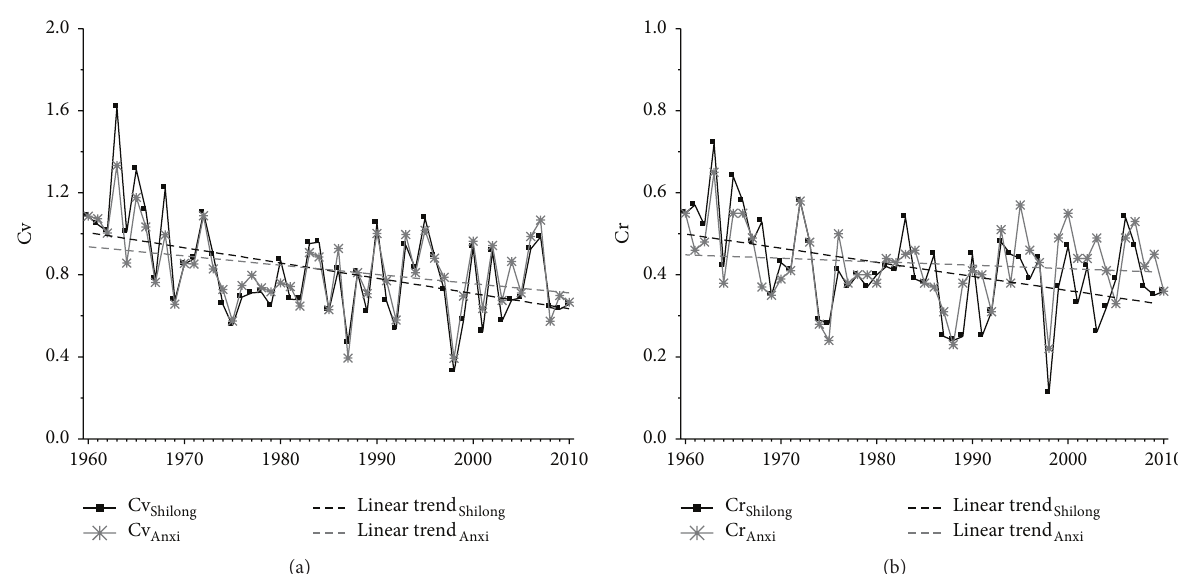
Figure 7: Interannual variation trend of streamflow in the Jinjiang River